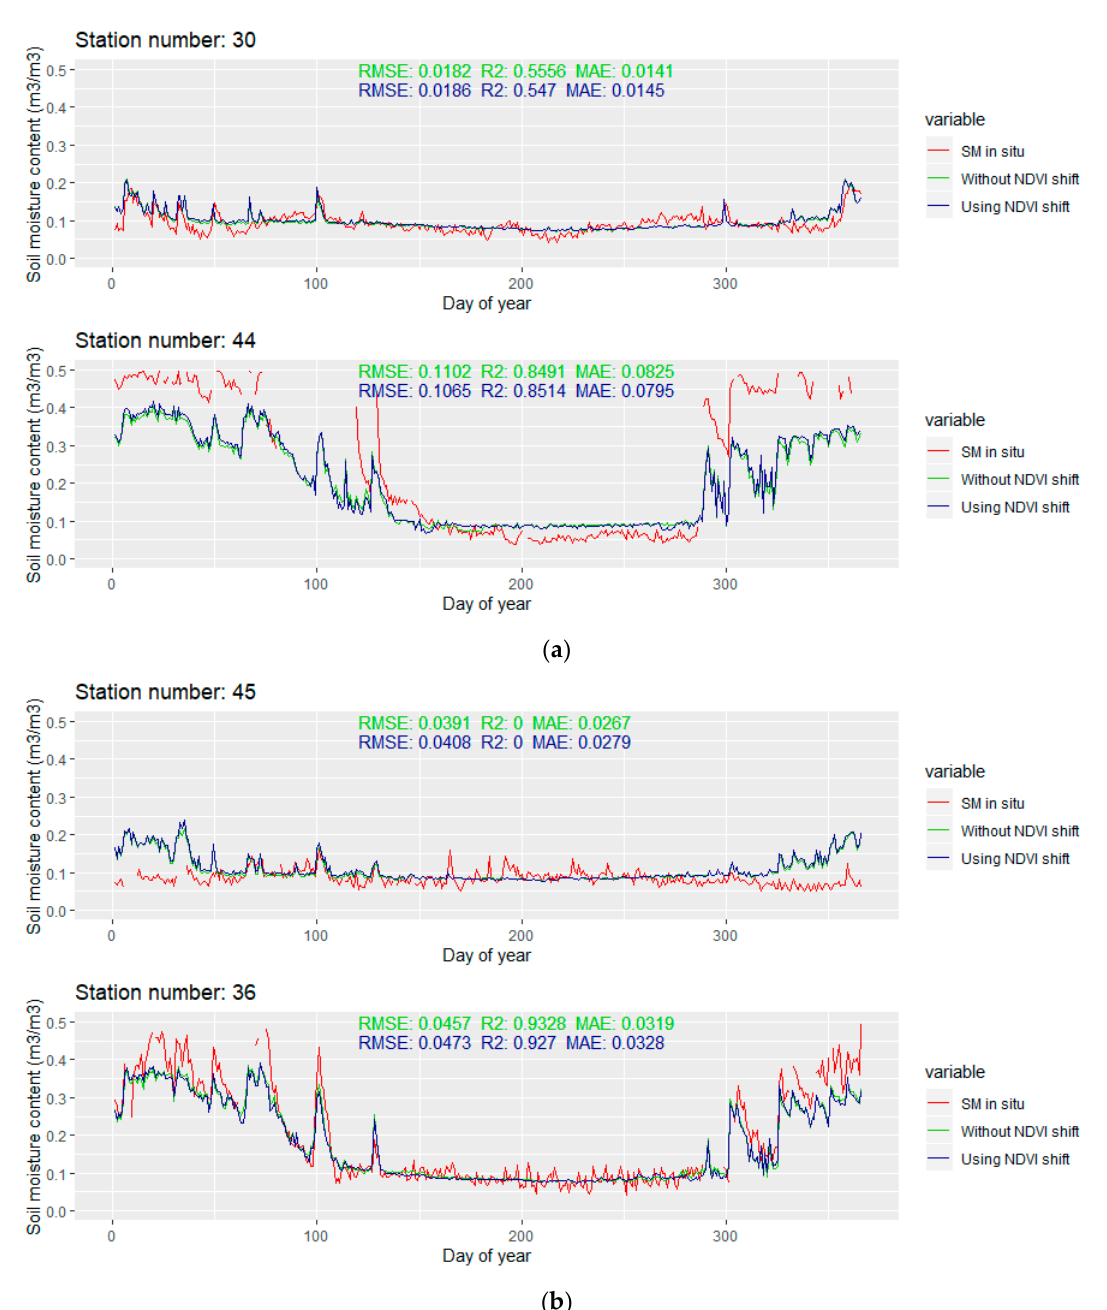
Figure 12. The temporal line plots of the stations with extreme values of RMSE and R 2 : (a) the minimum value of RMSE for Station 30 and the maximum value of RMSE for Station 44; and (b) the minimum value of R 2 for Station 45 and the maximum value of R 2 for Station 36.